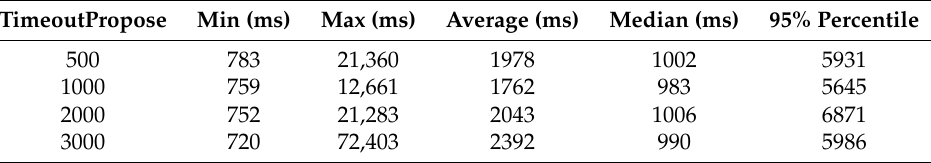
Table 8. Network latency with 16 producer nodes under failure